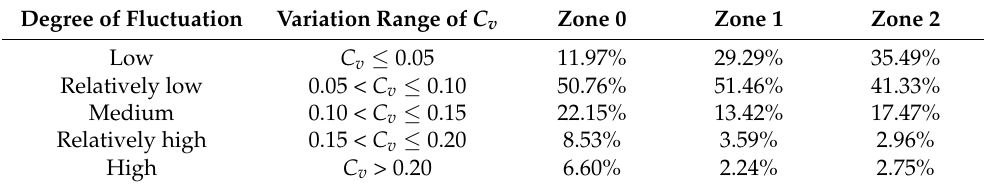
Table 4. Analysis on the stability of NDVI change from 2013 to 2020.